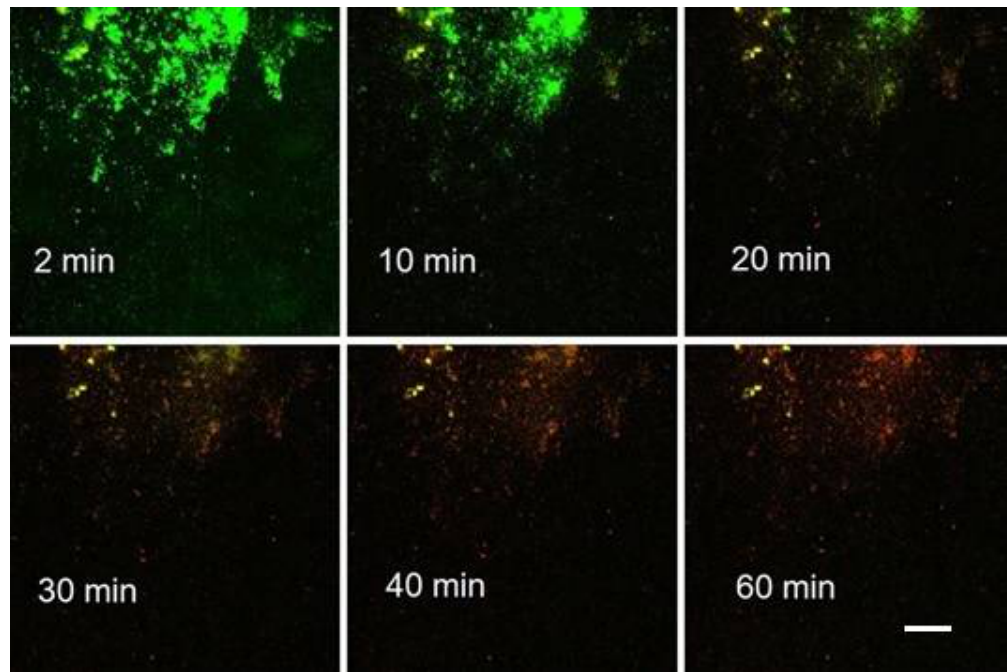
Figure 6. Points of a time series taken with a mixture of S. epidermidis and E. coli. Minutes are the time after bringing the leading edge of Product “A” over the biofilm. Snapshot obtained with 20x/0.8NA lens of AxioObserver microscope (composite images of green and red fluorescence; exposure of both emission channels 80 ms; scale bar in the 60 min frame applies to all frames = 100 μm).